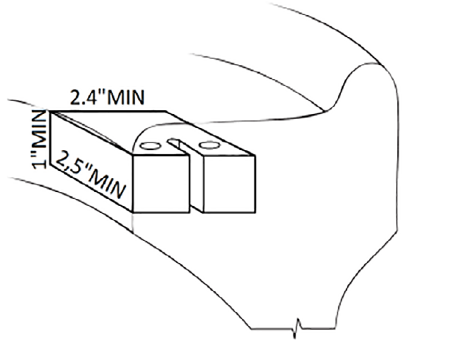
Figure 4. Fracture toughness specimen according to AAR appendix C